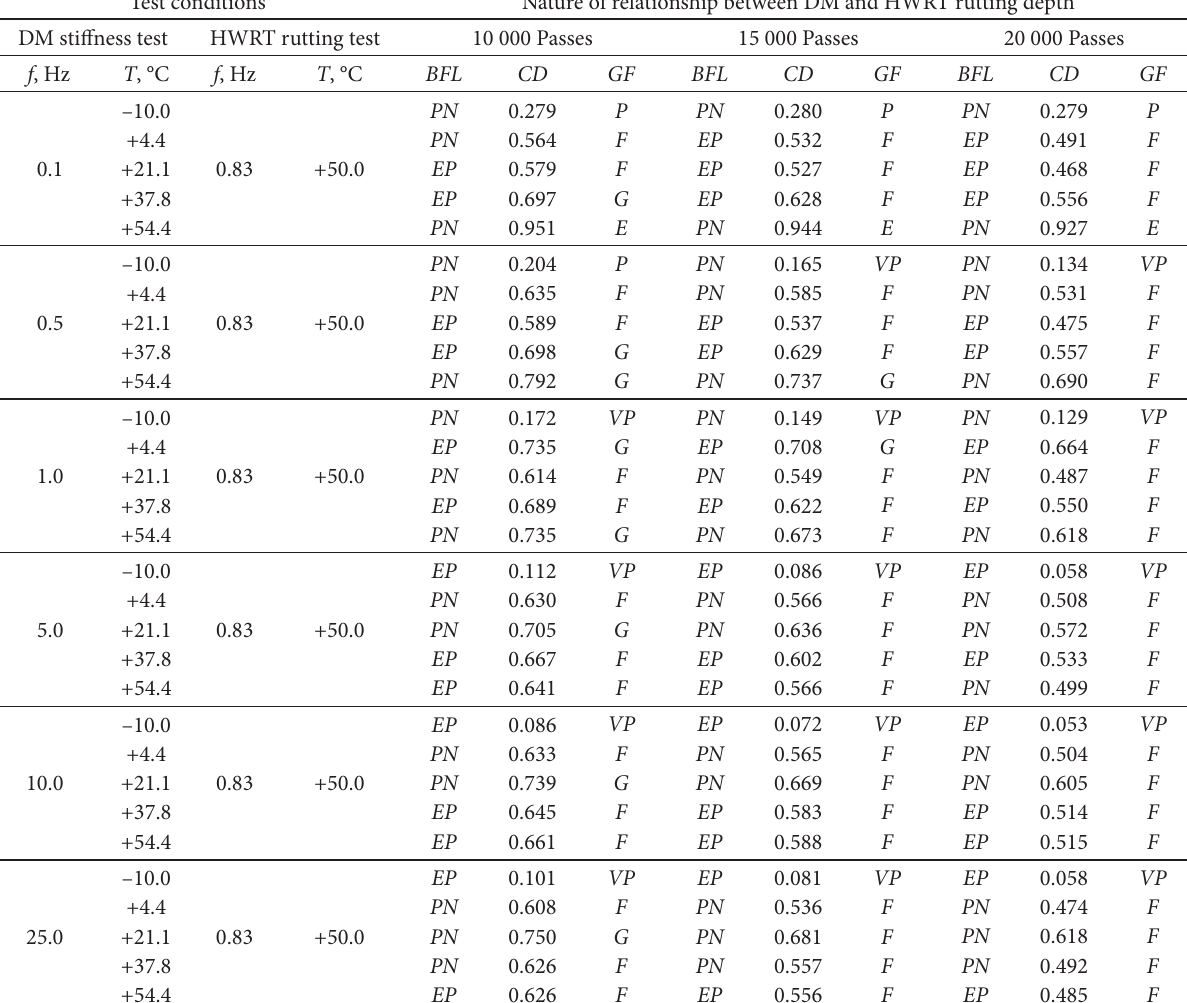
Table 9. Relationship between stiffness and HWRT rutting